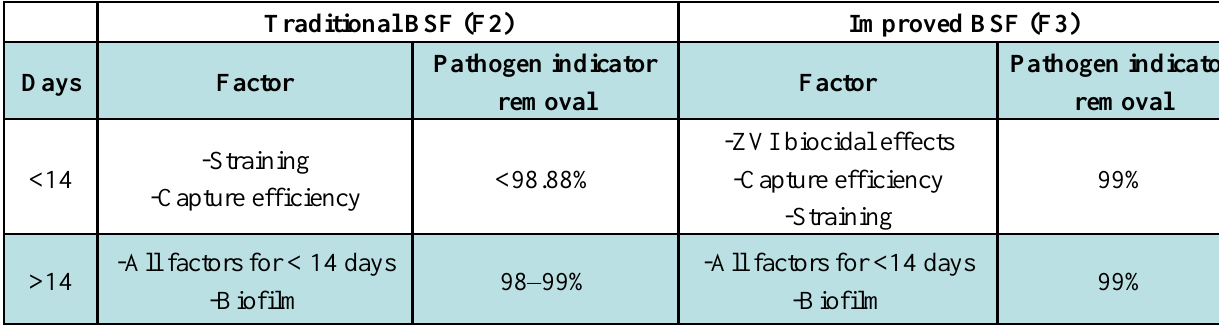
Table 4. Suggested factors involved in pathogen removal.